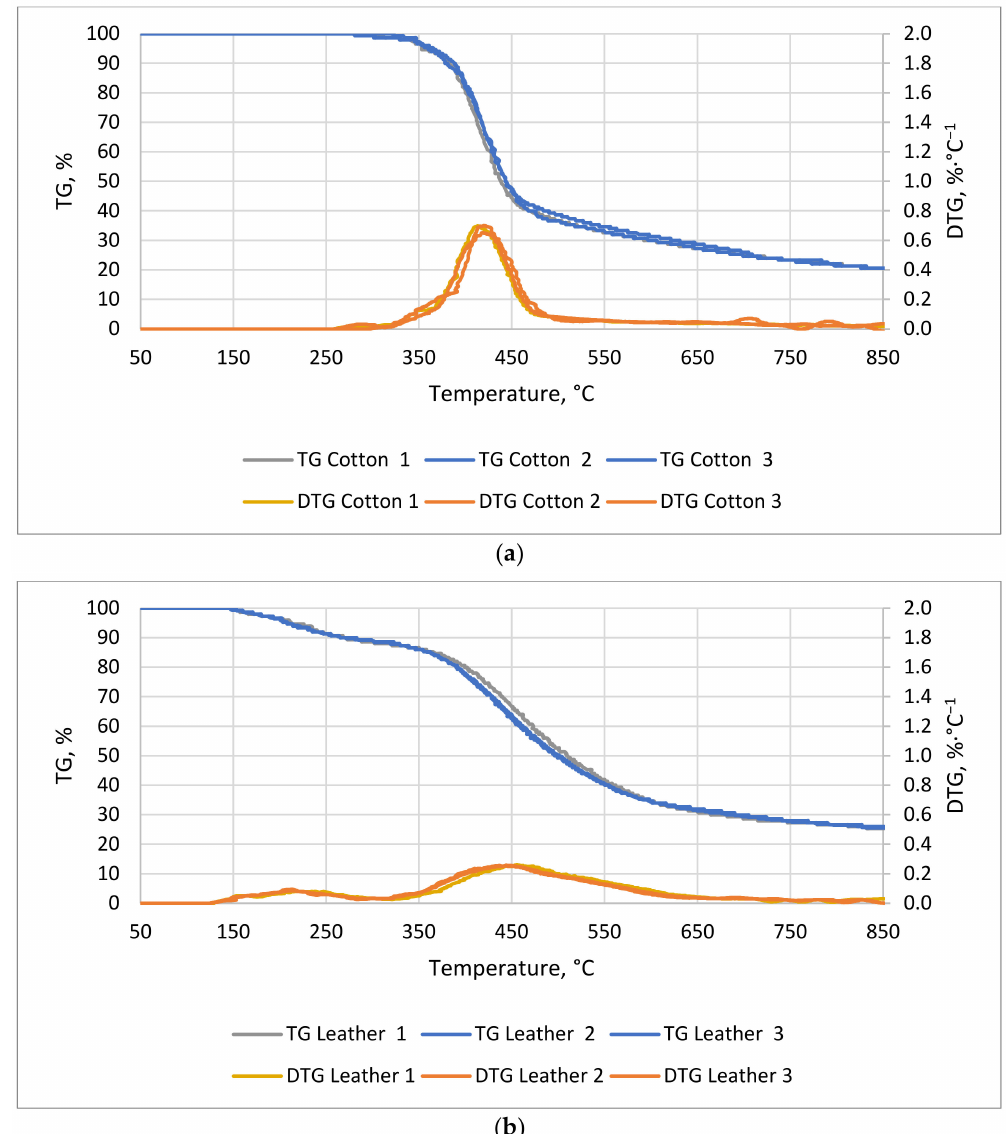
Figure 5. Characteristics of the TG/DTG of textile waste: ( a ) cotton textile; ( b) leather. The DSC characteristics of the cotton textile are shown in Figure 6a. Five transforma- tions are visible, one exothermic and four endothermic. The first transformation started at about 251 ◦ C. At this temperature, hemicellulose and cellulose, which are the main components of cotton, are broken down. In addition, further transformations that originate at about 310 to 415 ◦ C, respectively, are associated with these biopolymers